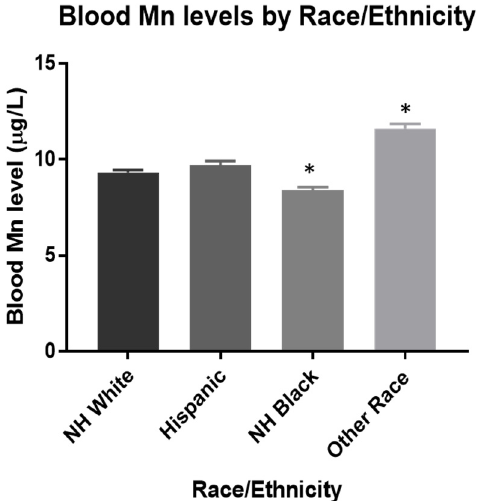
Figure 1. Estimated mean blood Mn levels were 9.3, 9.7, 8.4, and 11.6 µg/L for NH-White ( n = 988), Hispanic ( n = 385), NH-Black ( n = 491), and Other Race ( n = 204), respectively. * p < 0.0001. Data were analyzed by One-way ANOVA with Tukey’s post-hoc test holding NH White as the control. The limit of detection used was 0.99 µg/L.